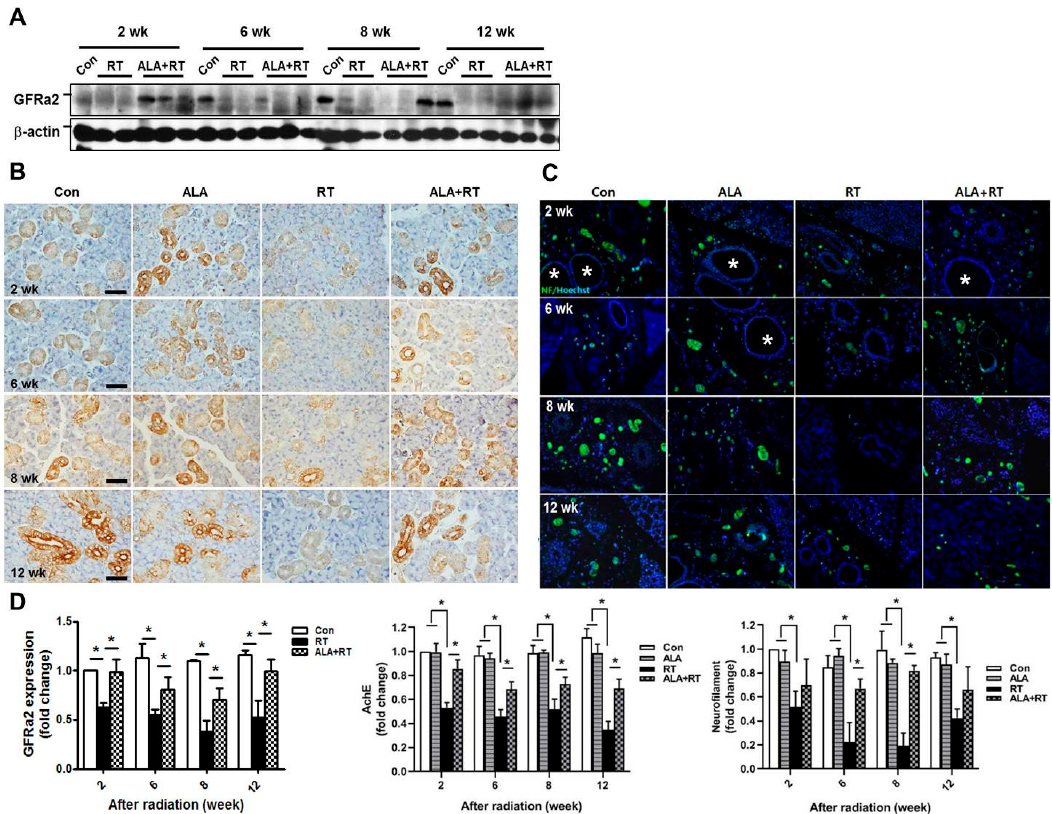
Figure 3. ALA rescues parasympathetic innervation in SGs . Sprague–Dawley rats were subjected to 18 Gy radiation in the head and neck region. ( A ) SGs were collected at each time points after radiation and subjected to Western blotting of GFR α 2. β -actin was used as the loading control. The expression of GFRa2 is normalized to β -actin, was shown as signal intensity, and the expression in each group was represented as fold change. The fold change is calculated as the ratio of the final value in each group to the value in control group at 2 weeks (set as “1”). Size markers mean 50 kDa. Con; control ( n = 3). RT; irradiation only group ( n = 4). ALA+RT; ALA plus irradiation groups ( n = 3). The immunohistochemical staining of AchE (brown in ( B) and neurofilaments (C ) was shown in representative images. * indicate the ducts in SGs in C. Scale bar, 50 μ m. N = 3–4 SGs/group. ( D ) Western blot and positive signals for each target were calculated as signal density. Values are represented as the mean ± SEM. * p <